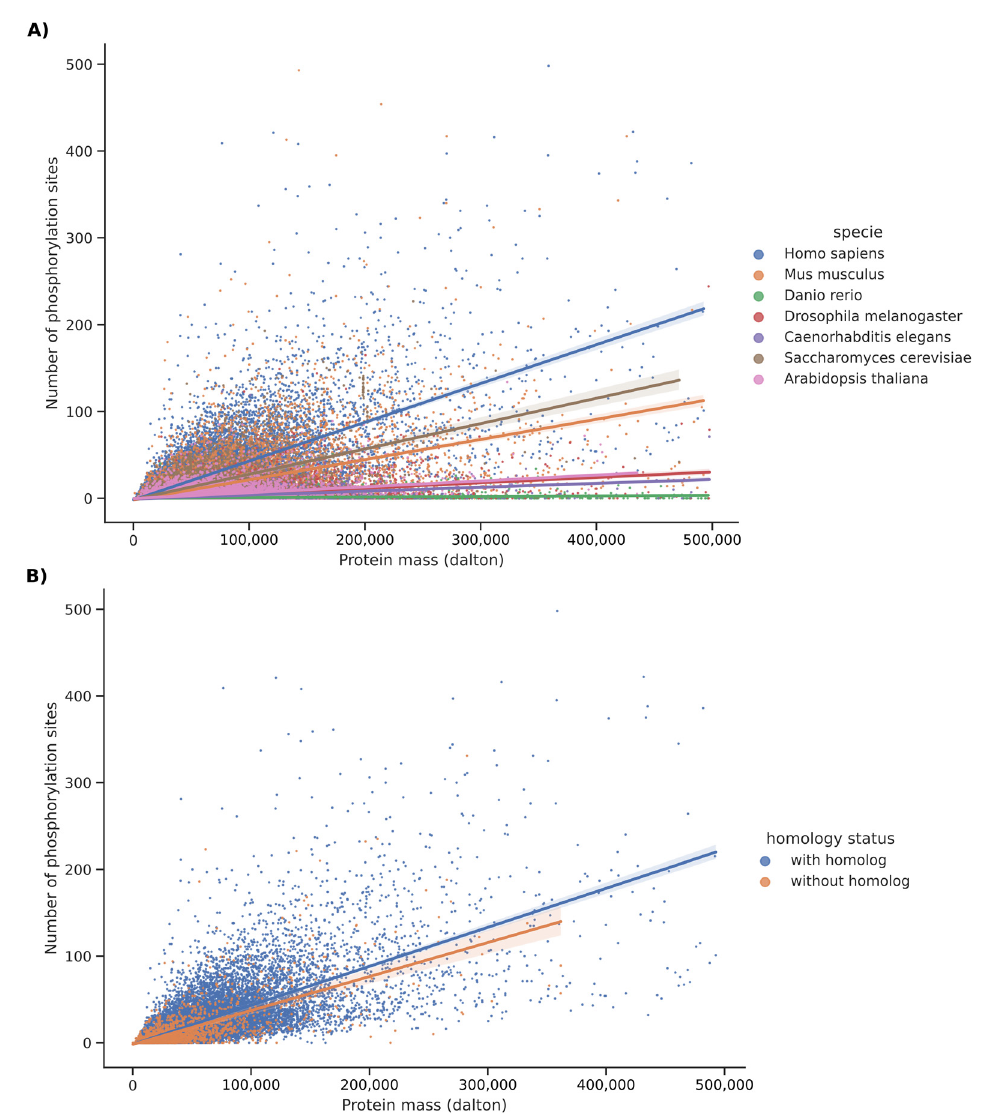
Figure 3. A plot of the relationship between masses and the number of phosphorylation sites. The study was carried out for each phosphorylated protein with a mass of less than 500,000 daltons and with less than 500 phosphorylation sites. ( A ) A plot regrouping the seven studied species. Regressions lines are drawn with a confidence interval of 0.95 (highlighted using translucent bands around the regression line). ( B ) A plot of phosphorylated proteins in Homo sapiens . Data in blue are for proteins that have at least one homolog in another species, while data in orange are for proteins without homolog. Regressions lines are drawn with a confidence interval of 0.95 (highlighted using translucent bands around the regression line).